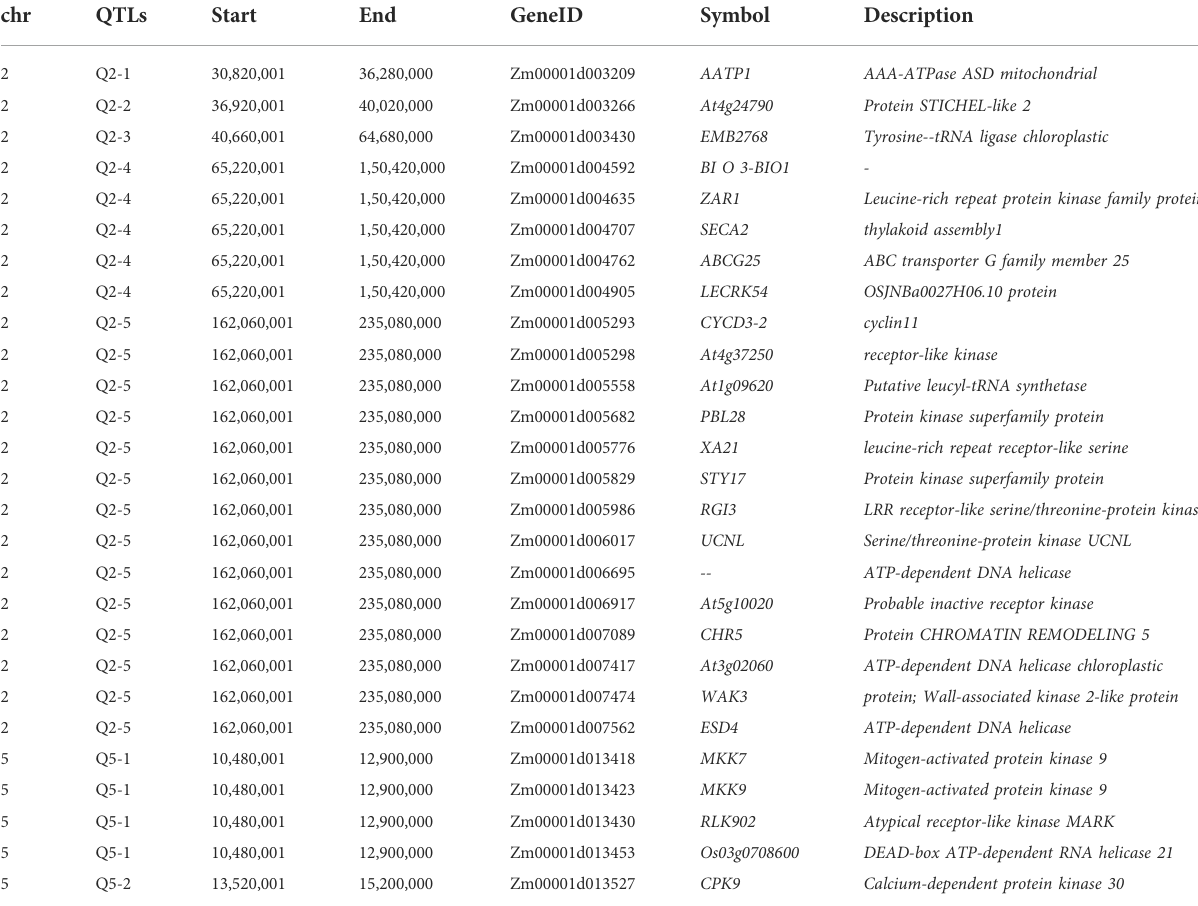
TABLE 2 Distribution of candidate genes associated with resistance to NCLB on Chr 2, and fi ve